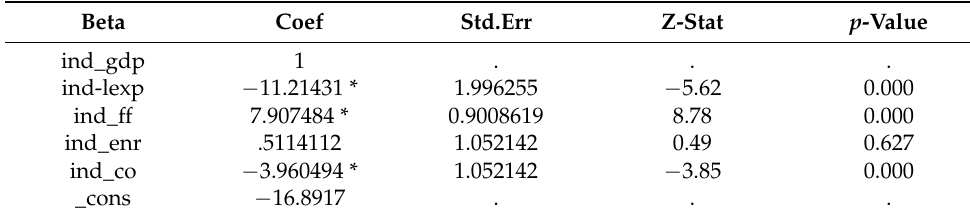
Table 14. Johansen normalization restriction imposed for India. Beta Coef Std.Err Z-Stat p -Value ind_gdp